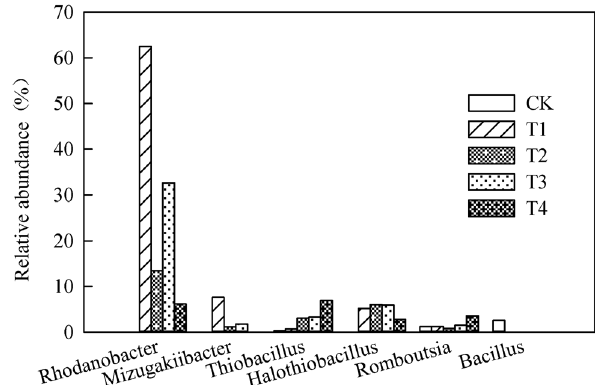
Figure 7: Predominant bacterial genera in di ff erent vermicompost